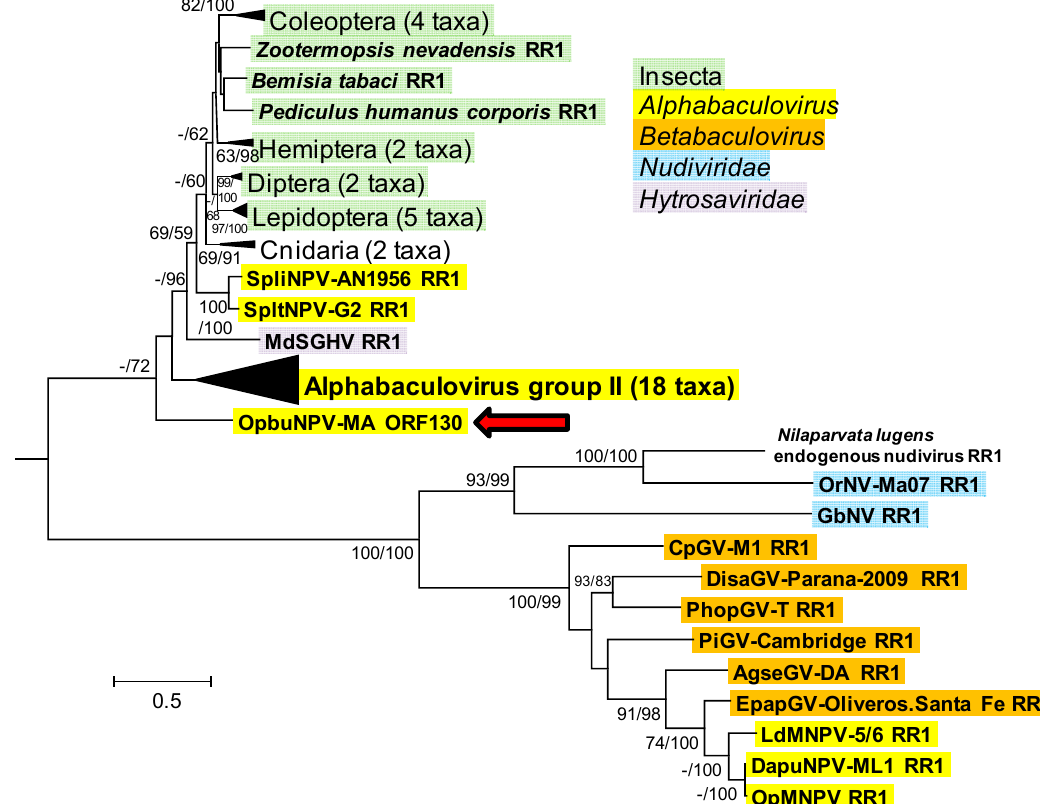
Figure 8. Phylogenetic inference from aligned viral and cellular ribonucleotide reductase large subunit (RR1) homologs. An ML phylogram inferred from the alignment of RR1 amino acid sequences is shown with bootstrap values (>50%) at interior branches for ME and ML analysis (ME/ML) where they occur. The sequence for Bacillus thuringiensis IBL200 RR1 (GenBank accession no. EEM97377) was included as an outgroup. The classification of each taxon is indicated with a color-coded text background, except for unique taxa of phylum Cnidaria and the Nilaparvata lugens endogenous nudivirus (which is not actually classified as a nudivirus). Branches for RR1 sequences from phylum Cnidaria; the insect orders Coleoptera, Diptera, Hemiptera, and Lepidoptera, and group II alphabaculoviruses are collapsed, and the numbers of taxa in each of these nodes are indicated in parentheses. The OpbuNPV sequence is indicated with a red arrow. The sequences in this tree and their accession numbers are as listed in Table S1.